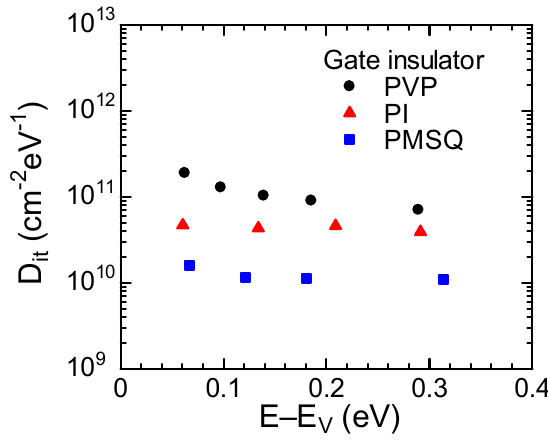
8 of 11 Figure 7. ( a ) Plot of the equivalent parallel conductance loss ( (cid:1833) (cid:3043) /(cid:2033) ) versus frequency for the P3HT MIS capacitor with the PI gate insulator at a gate voltage ( V G ) of 0 V. The dashed blue line, dashed- dotted red line, and solid black lines represent the fitted results using Equations (3), (4) and (7), respectively. ( b ) Fitted results for the frequency dependence of (cid:1833) (cid:3043) /(cid:2033) of the ITO/PI/P3HT/Au MIS capacitor at different gate voltages using the statistical model. Figure 8 shows the densities of interface states above the valence band edge ( (cid:1831) (cid:3049) ) in the P3HT MIS capacitors with the different polymer insulators of PI, PVP, and PMSQ, calculated using the statistical model. The energy scale was determined by the conventional (cid:1829) – (cid:1848) method [30]. The energy level was calculated from the surface potential ( (cid:2032) (cid:3020) ) at (cid:1848) (cid:3008) , which is given as follows